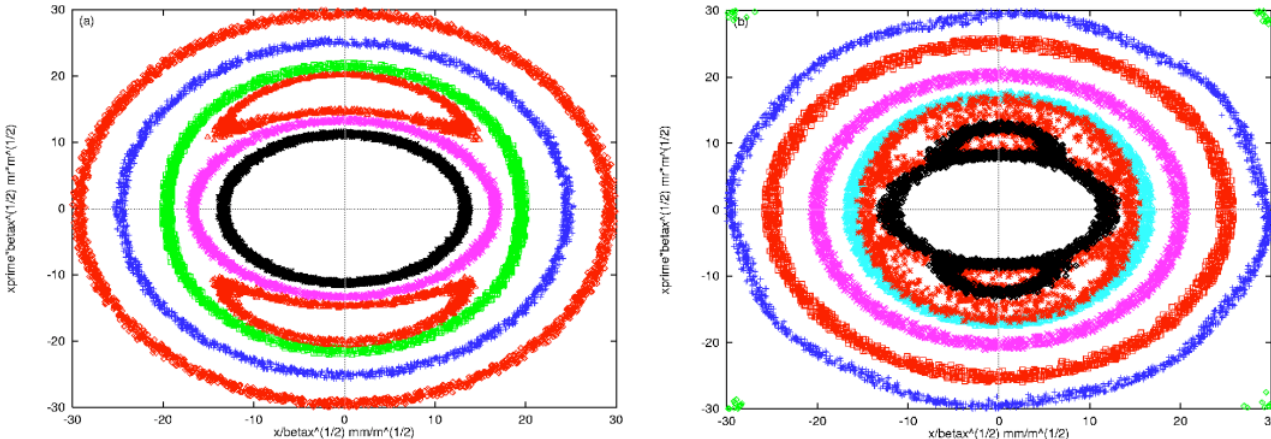
FIG. 12. (Color) PCM Poincaré plots of horizontal phase space for (a) horizontal and (b) coupled x - y motion for the SNS FODO lattice with 20% rms radial mismatch with 2 3 10 14 particles.